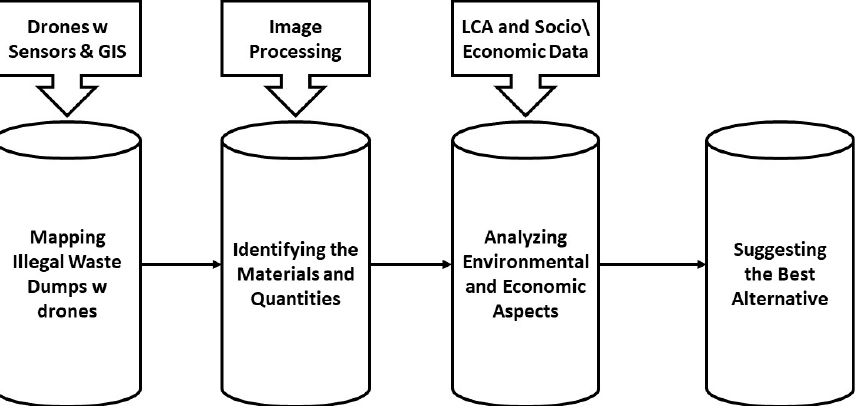
Figure 1. Methods overview. Multi-method approach using remote imaging, GIS, image processing, and LCA data to identify, analyze, and find the best solution for treating illegal waste dumps.